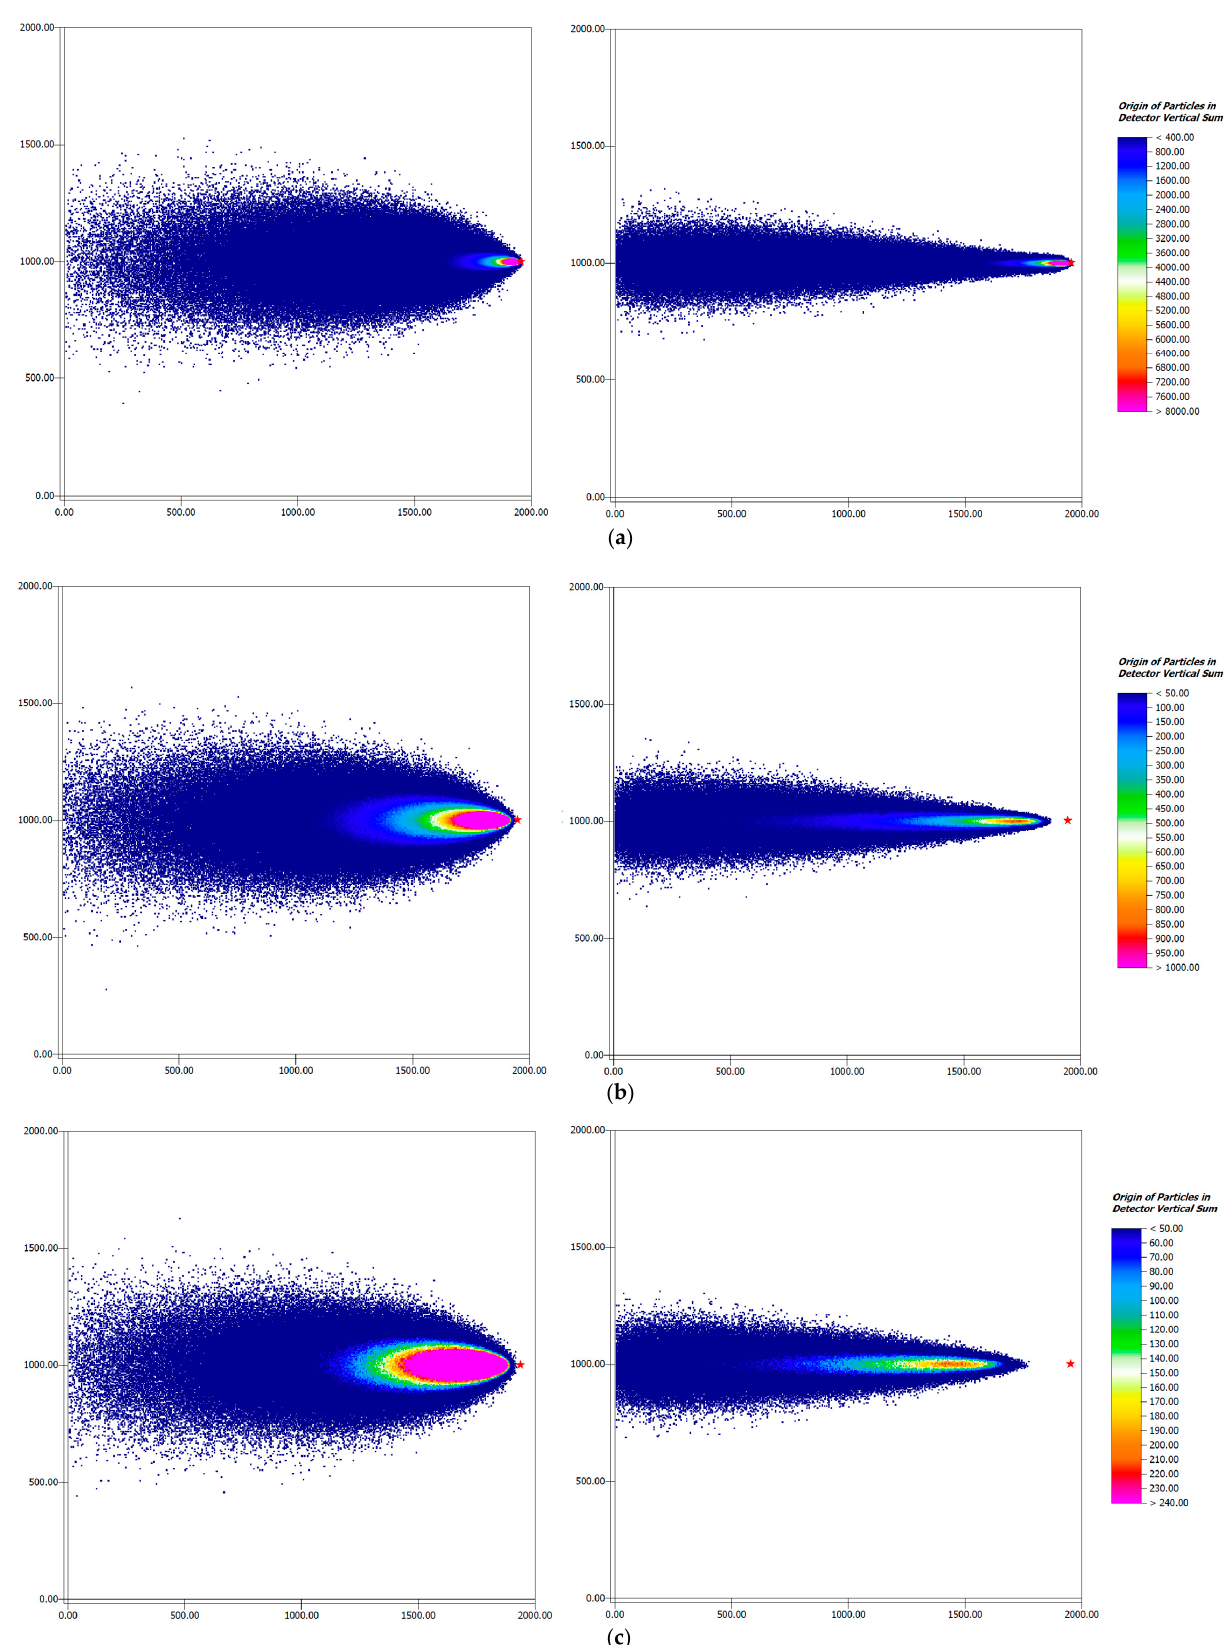
Figure 7. Origin of particles modelled for the unstable cases (left) and the stable cases (right) featuring detector heights of 3 m ( a ), 20 m ( b ) and 40 m ( c ) for the homogenous model area. Red star indicates detector position.